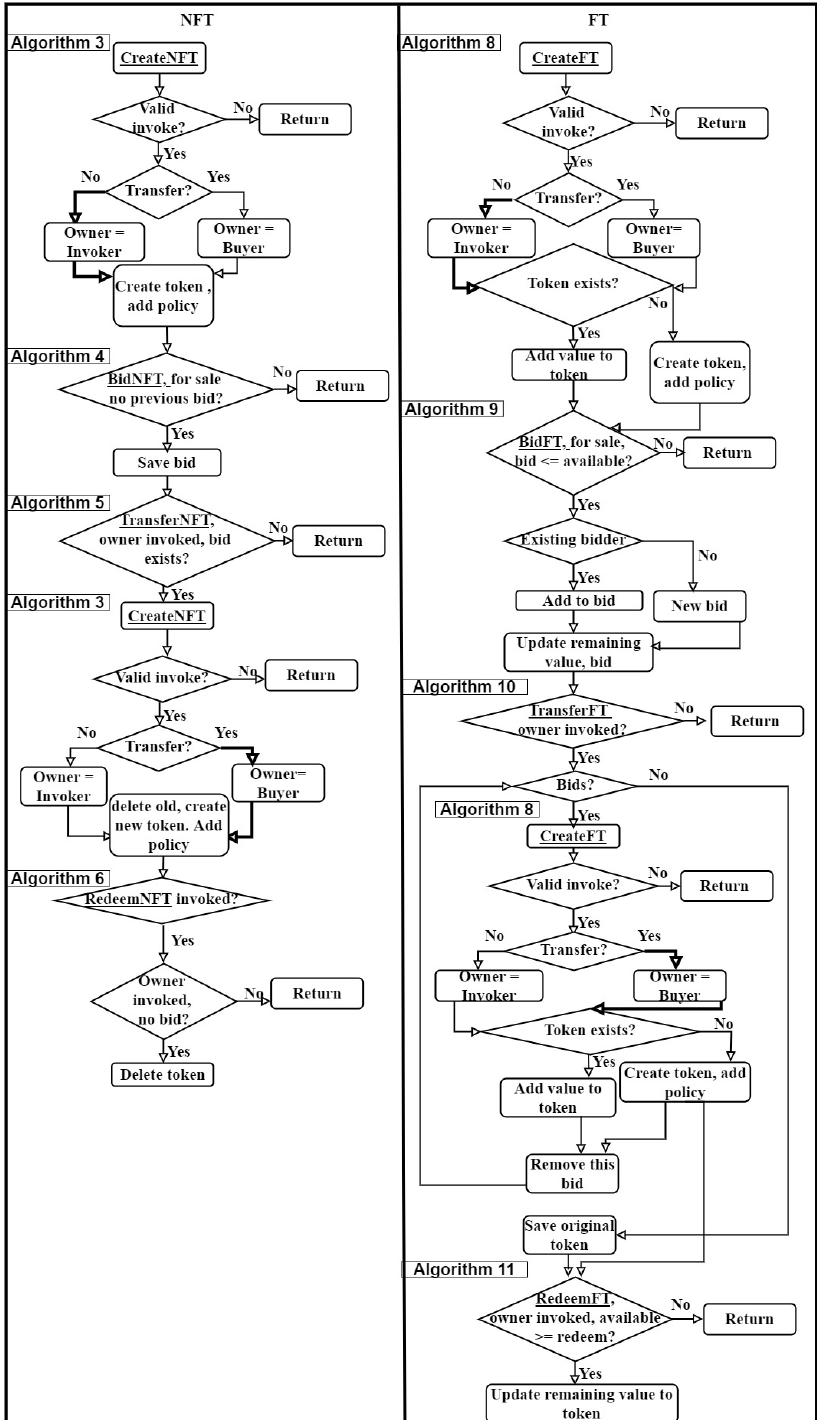
Figure 4. Lifecycle for Fungible Tokens (FT) and Non Fungible Tokens